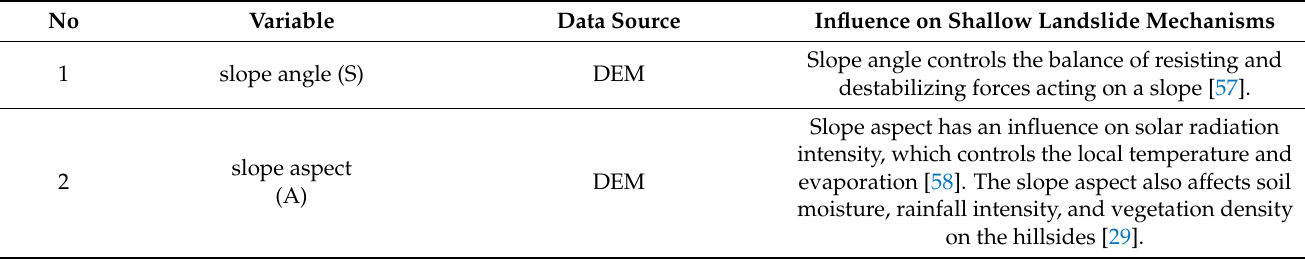
Table 2. Explanatory variables used in SLI analysis and their influence on shallow landslide